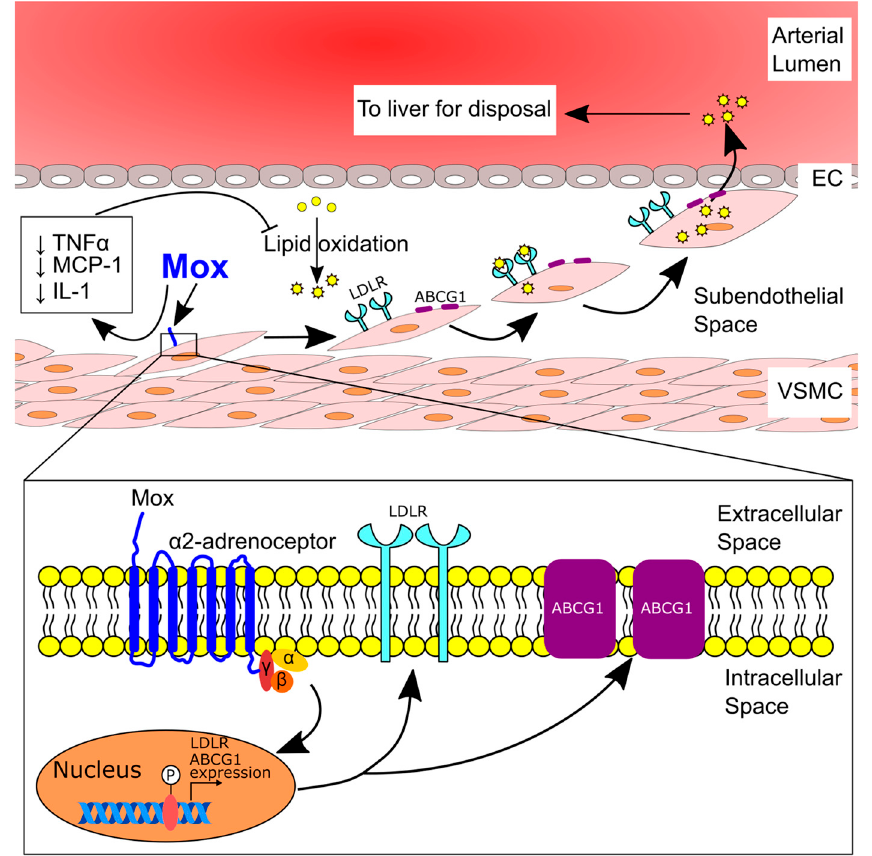
Figure 8. Hypothesis: proposed mechanism underlying moxonidine-induced inhibition of atherosclerosis. Moxonidine decreases the expression of inflammatory genes (e.g., TNF- α ), which inhibit the oxidation of LDL. Moxonidine enhances VSMC migration. These VSMCs then migrate to a location that could facilitate both oxidised LDL uptake via the LDL receptor and its efflux back to circulation via the ABCG1 transporter for detoxification and elimination by the liver. Thus, moxonidine may inhibit atherosclerosis by inhibiting inflammation and promoting oxidised LDL clearance from the atherosclerotic plaque. ABCG1, ATP binding cassette subfamily G member 1; EC, endothelial cell; IL, interleukin; LDL, low-density lipoprotein; LDLR, low-density lipoprotein receptor; MCP-1, monocyte chemoattractant protein-1; Mox, moxonidine; TNF- α , tumour necrosis factor- α ; VSMC, vascular smooth muscle cell.